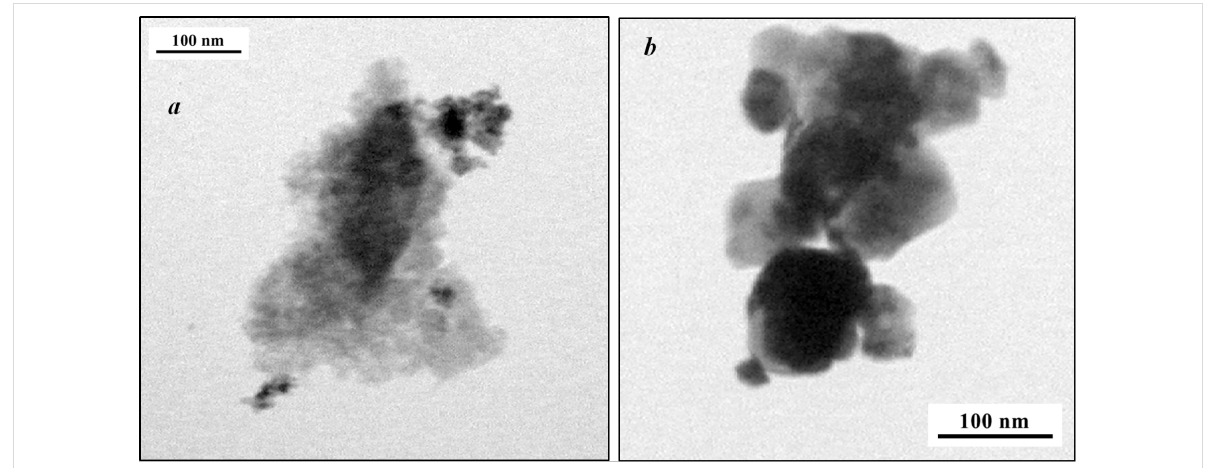
Figure 6: TEM images of CeO 2 nanopowder obtained from the cryosol (a) and CeO 2 nanopowder obtained from a freshly prepared sol without cryotreatment (b), showing that the cryotreatment results in a better-dispersed nanopowder with smaller crystallite size.